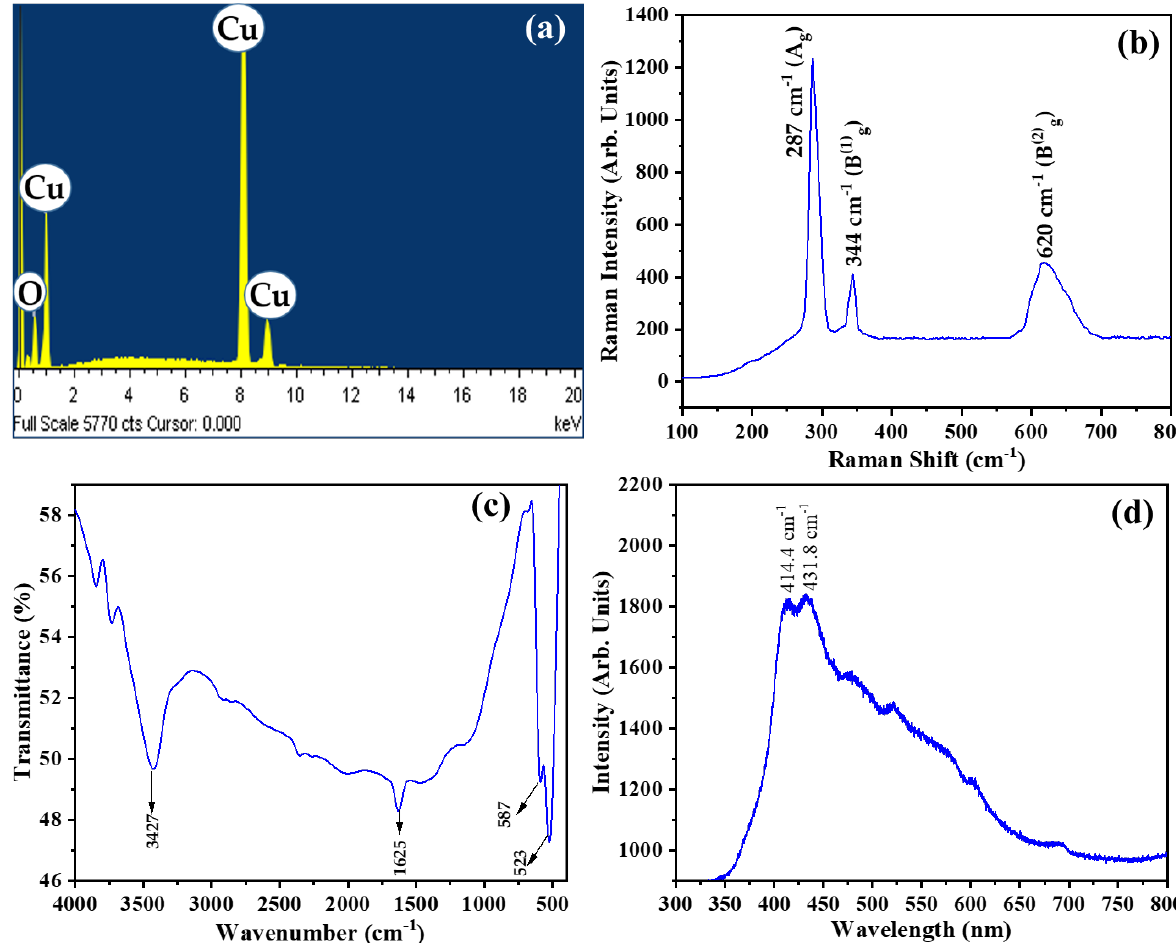
Figure 4. ( a ) Typical EDS spectrum, ( b ) Raman spectrum, ( c ) FTIR spectrum and ( d ) Photoluminescence spectra of leaf-shaped CuO nanosheets.